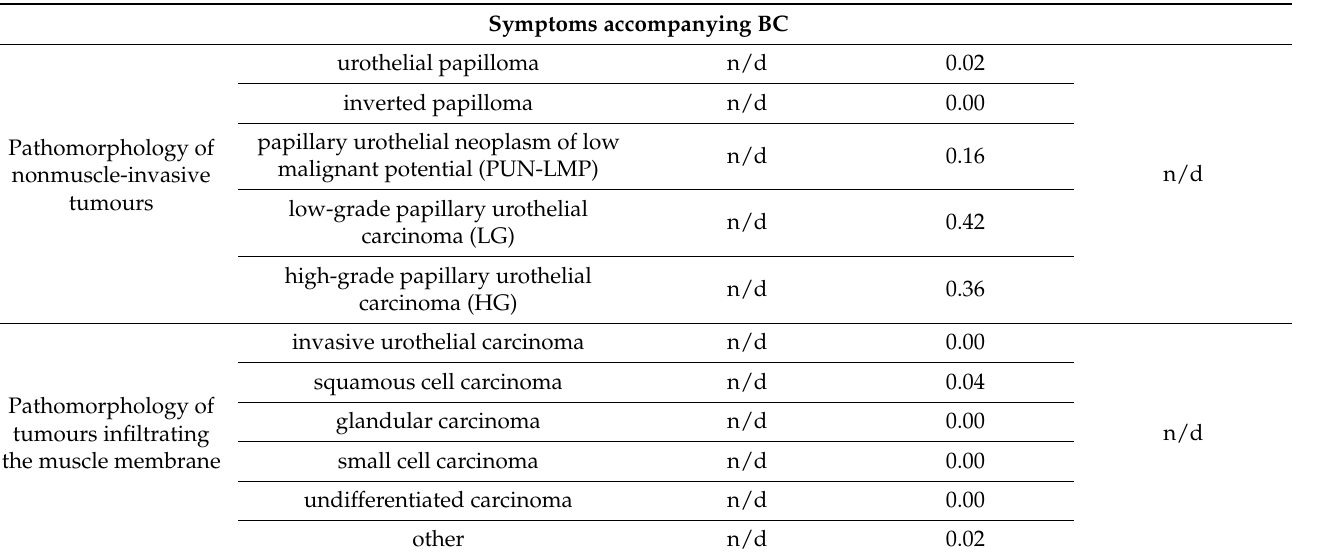
Table 1. Cont. Symptoms accompanying